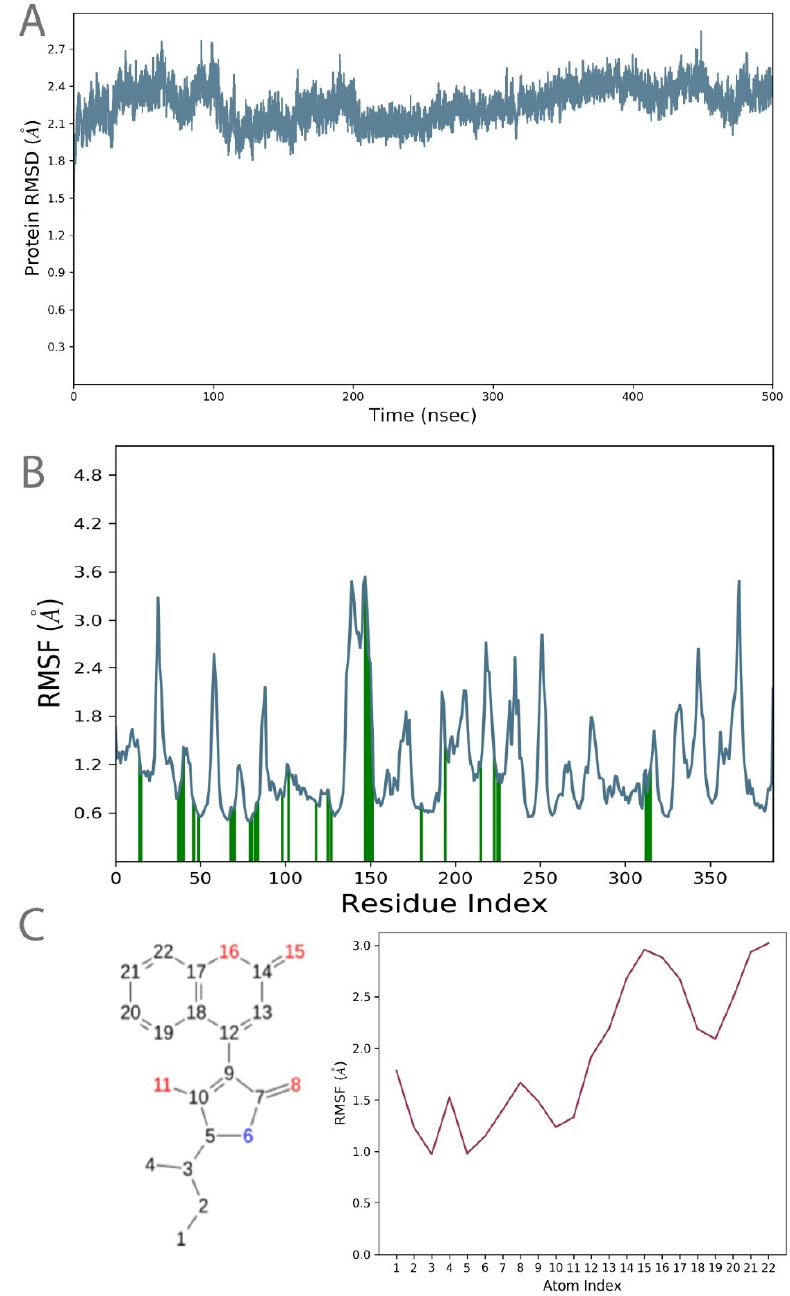
Figure 3. Plots depicting the results of molecular dynamics simulations. ( A ) Protein RMSD plot with the RMSD changes of C alpha atoms versus time in nanoseconds. ( B ) Protein RMSF plot of individual residues plotted against fluctuations observed. The ligand contacts are shown in green bars. ( C ) Ligand RMSF plot of the principal compound plotted with ligand atoms numbered in sequential order.